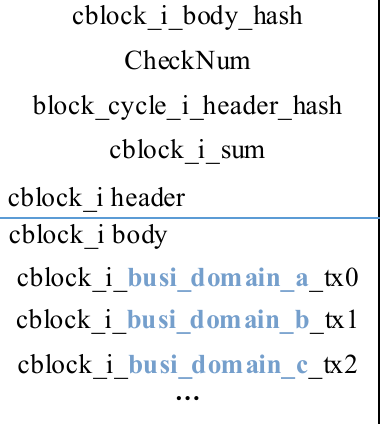
Figure 8. The structure of checking